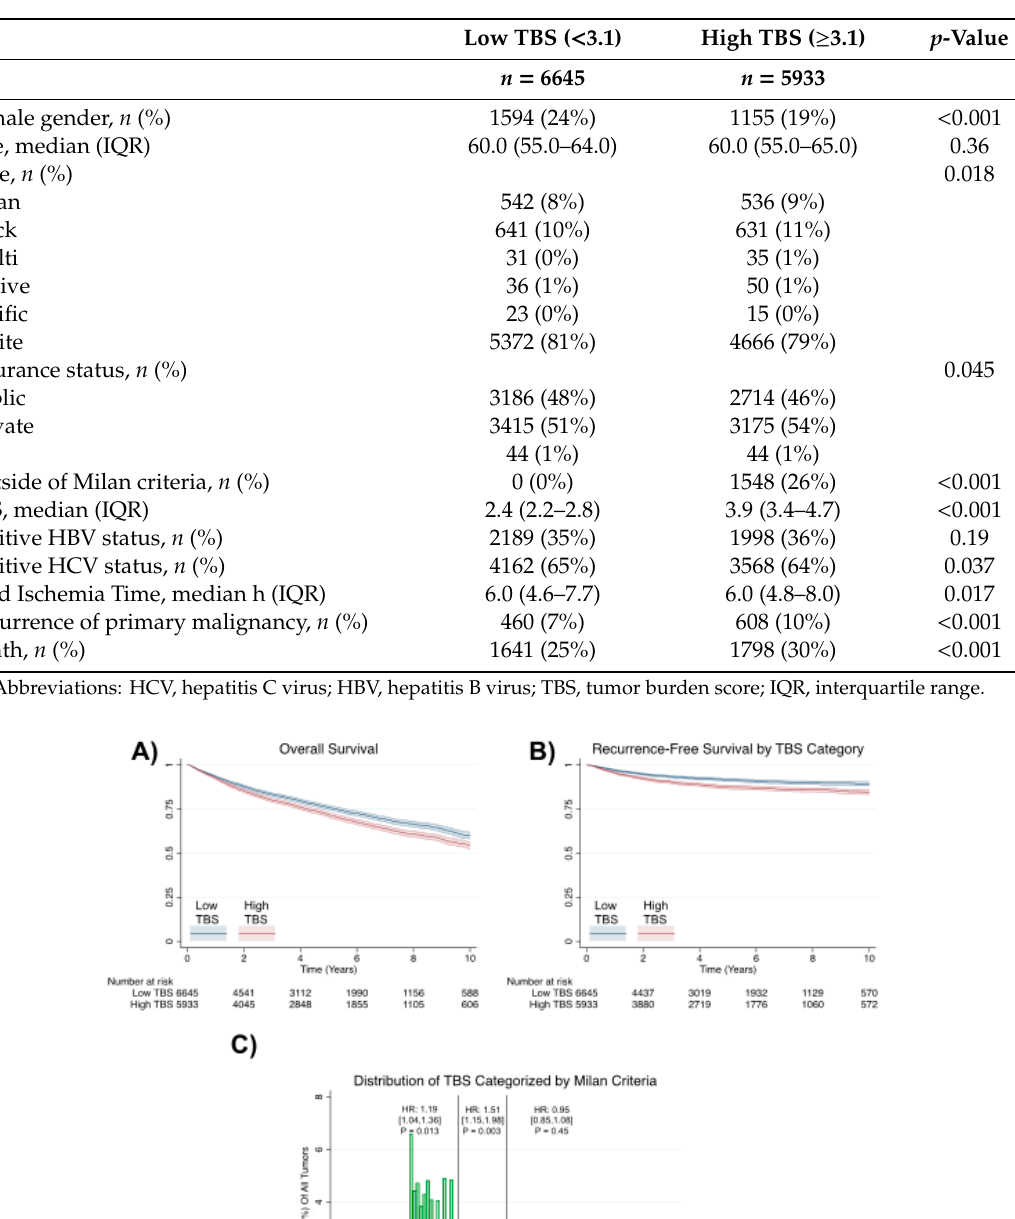
Table 1. Demographics stratified by the tumor burden score.